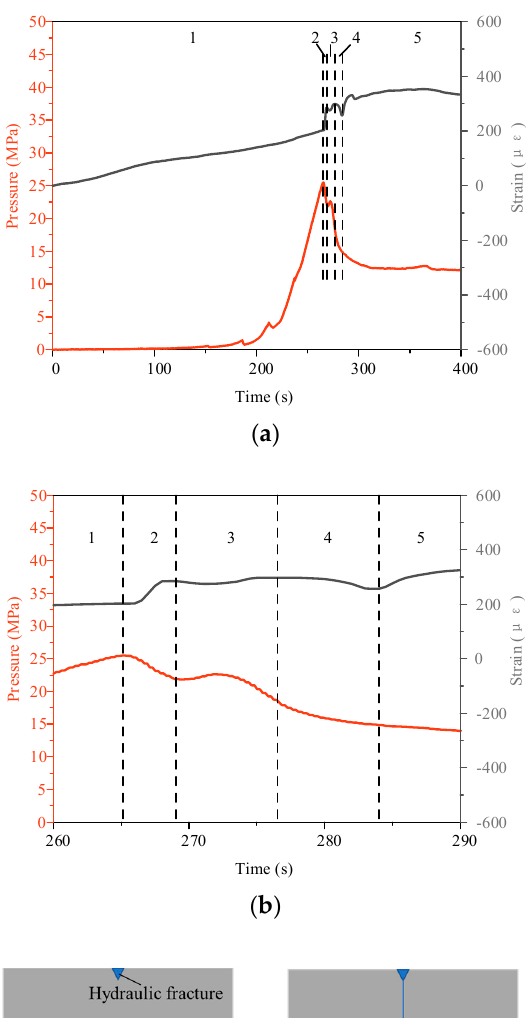
Figure 9. Arrangement pattern of resistance strain gauges (cluster spacing of 60 mm).